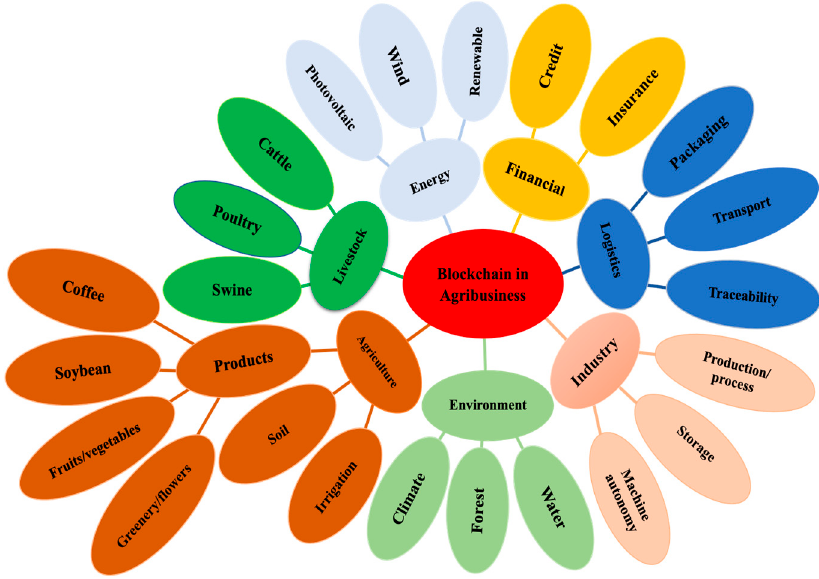
Figure 5. The purposes for which blockchain has been applied in the agribusiness sector.